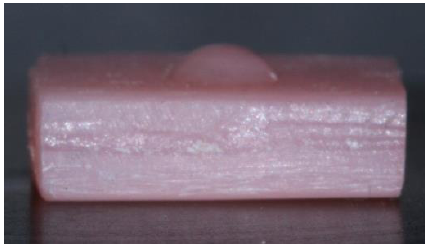
Fig. 2. Denture base specimen with 10 microlitre drop of human saliva.